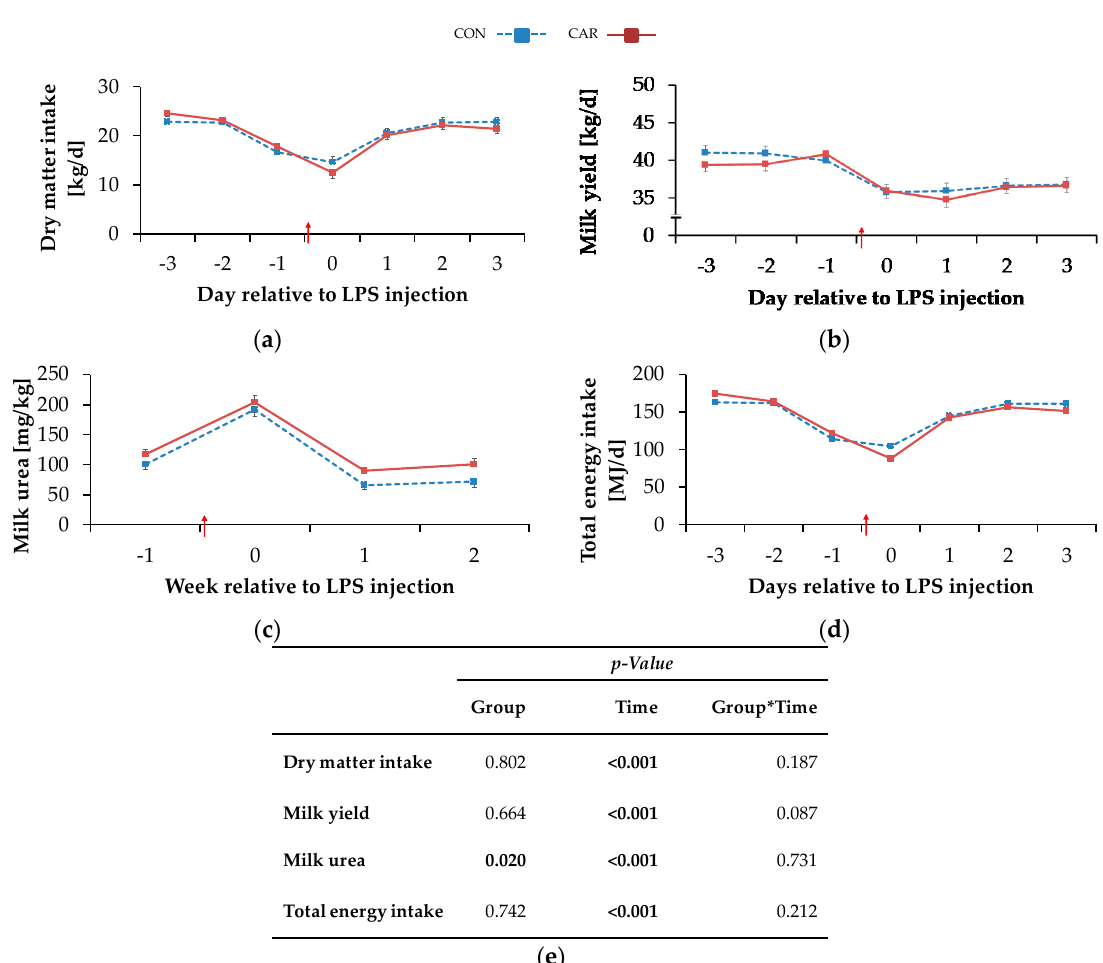
Figure 2. Progression of performance and feed intake data of dairy cows fed a non-supplemented (CON) or an L-carnitine supplemented diet (CAR, 25 g/d from 6 weeks ap up to day 126 pp) before and after an intravenous injection of 0.5 μ g/kg BW lipopolysaccharides (LPS) on day 111 pp (red arrow). ( a ) Daily dry matter intake, ( b ) daily milk yield, ( c ) milk urea, ( d ) daily total energy intake, ( e ) data statistics. Data are given as LS-Means standard errors. Significant p -values are marked as bold.